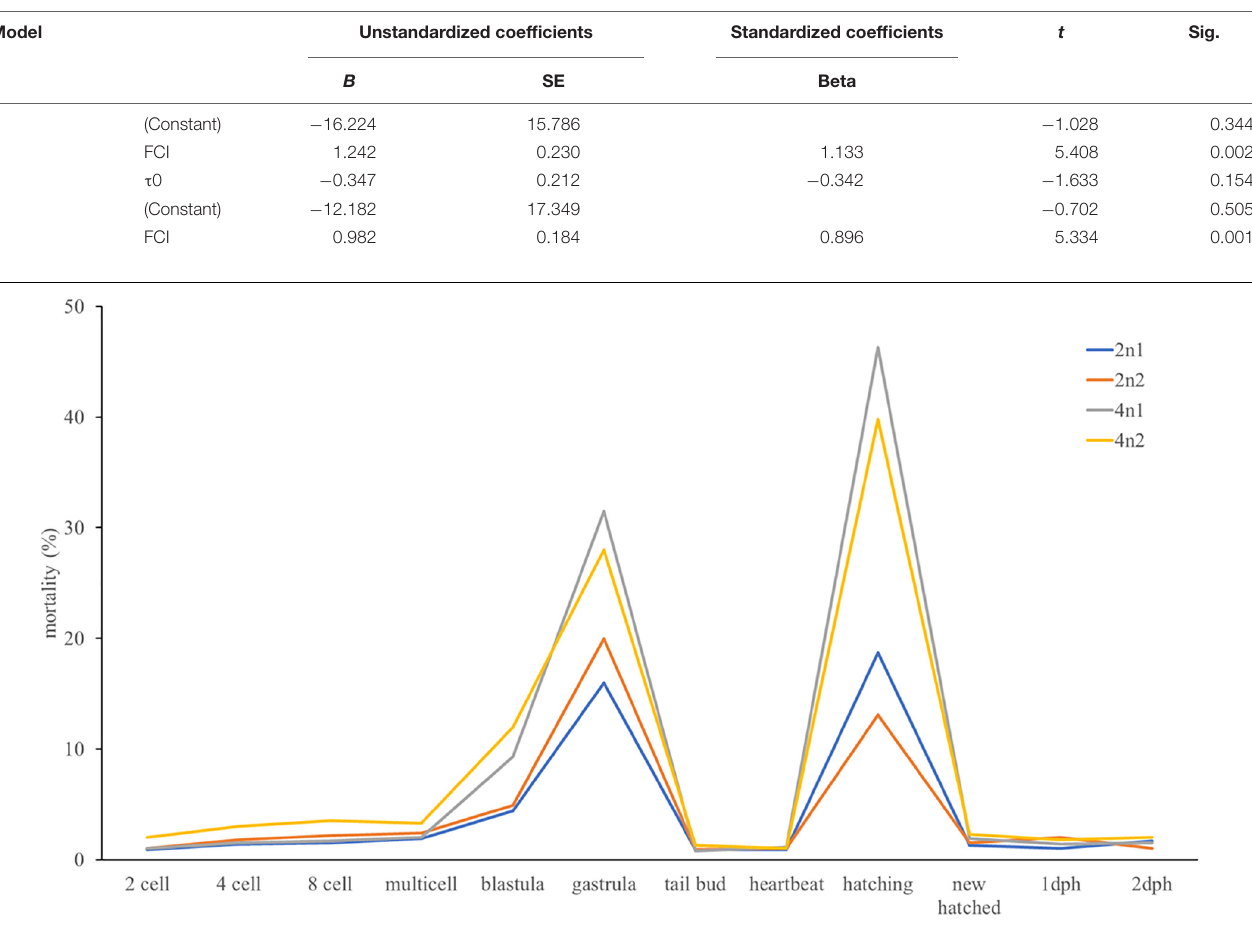
TABLE 3 | The coefficient of regression analysis of optimal initiation time, FCI, and τ 0. Model